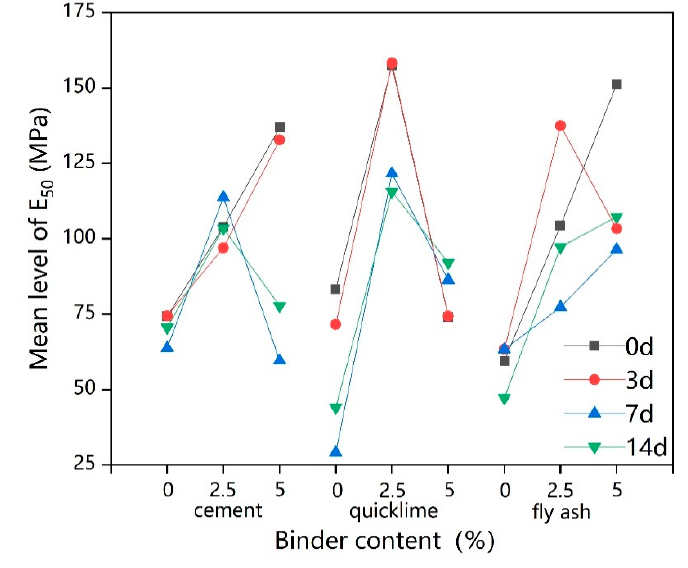
Figure 7. Intuitive trend chart of influencing factors for E 50